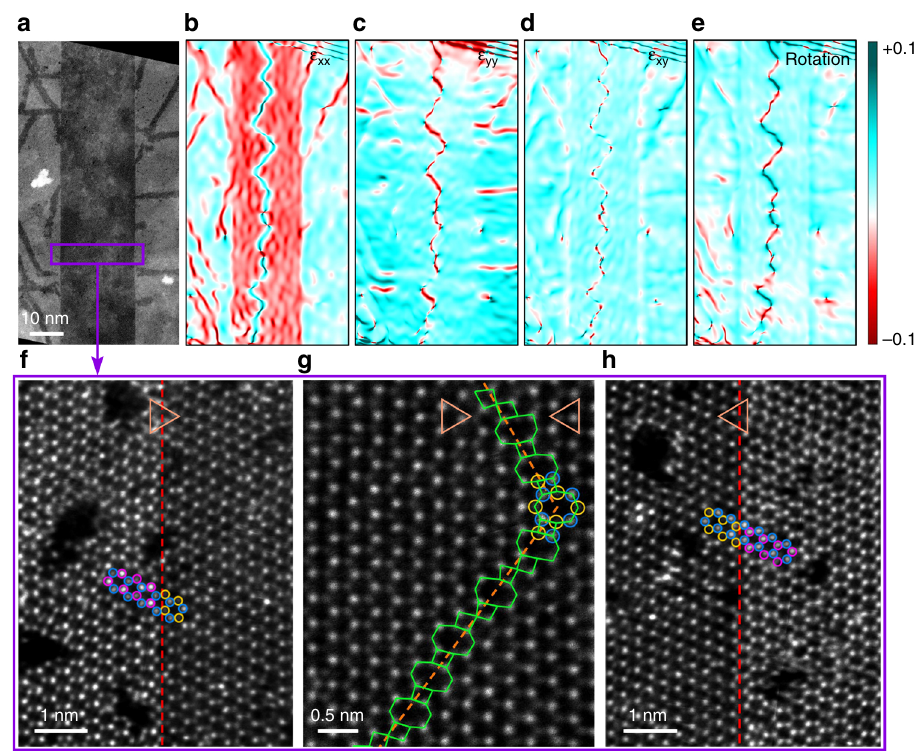
Fig. 3 Strain maps and structure analysis of straight nano-channels. a Low-magni fi cation ADF-STEM image showing a part of straight MoS 2 nano- channel with the width of ~20 nm. b – e The corresponding strain ( b – d ) and rotation ( e ) maps of the channel area, showing the lattice strain and local orientations with respect to reference lattice (MoSe 2 ). A zigzag GB can be found at the middle of the straight channel. f – h Atomically resolved ADF-STEM images of the rectangular region in a . Red dashed lines denote the left ( f ) and right ( h ) interface of the channel, respectively. Orange dashed line in g marks the 60° GB within the channel, and it consists of alternate 4|8 rings as indicated by green tetragons and octagons. The lattice orientations at two sides of GB can be recognized from the triangles on the top and the highlighted atoms by circles (Mo, blue; Se, purple; S,